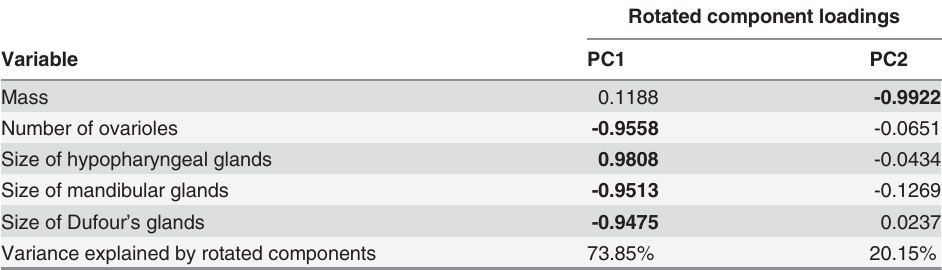
Table 2. Principal component loadings of the measured ontogeny of workers reared in different conditions.